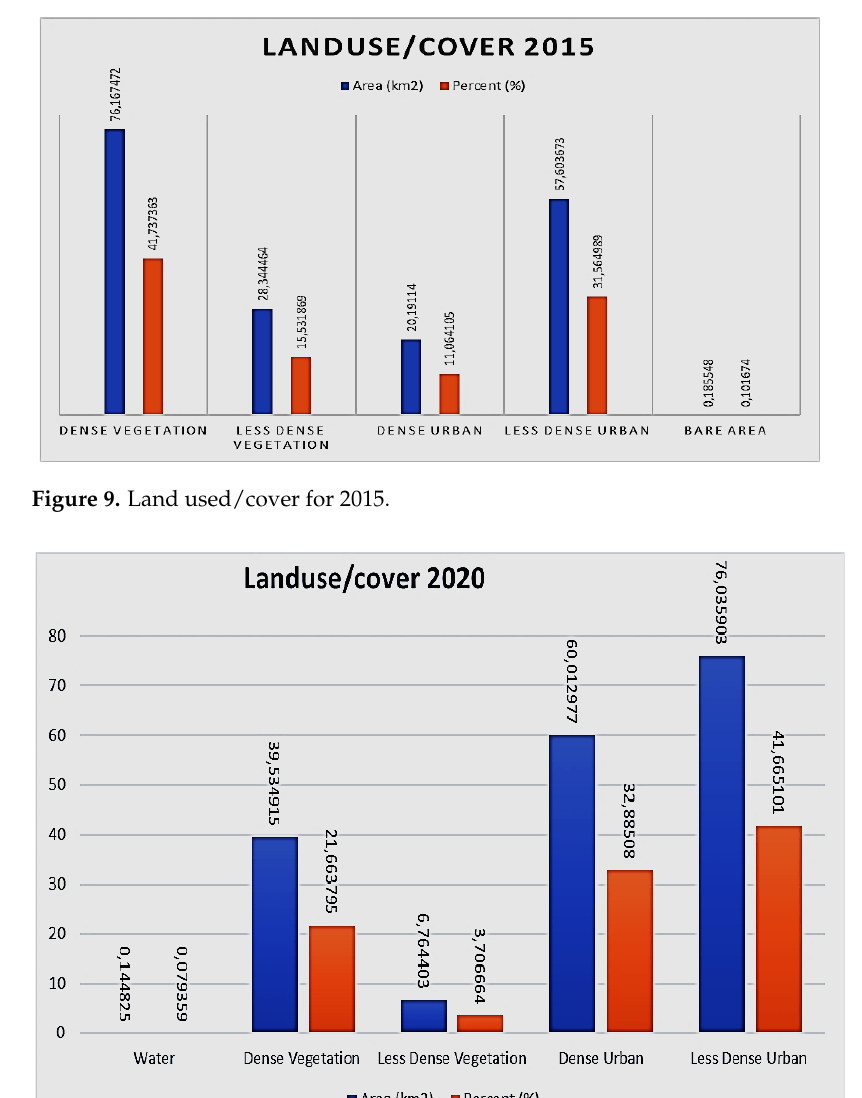
Figure 8. Land used/cover for 2010.